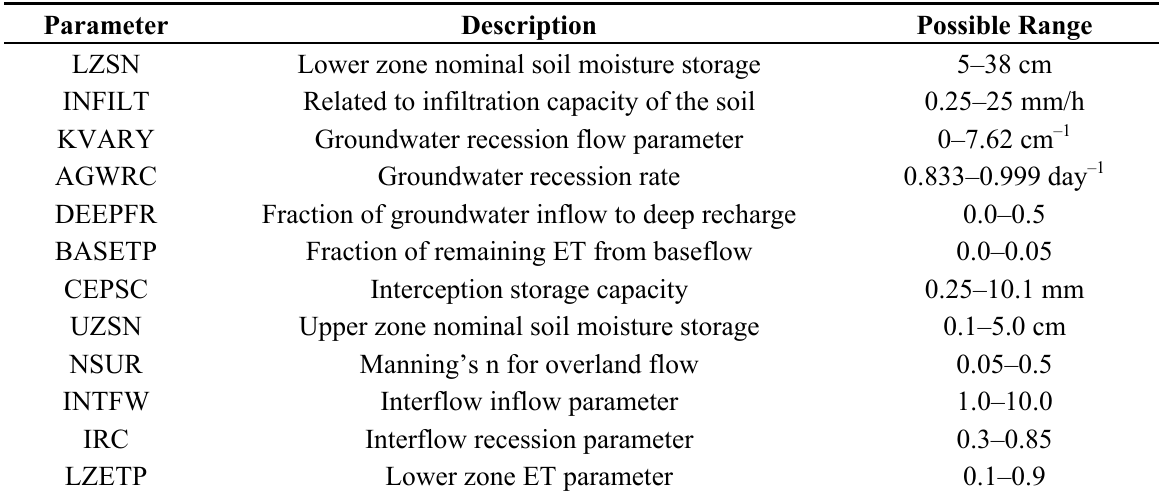
Table 2. Calibration parameters and possible range of value.